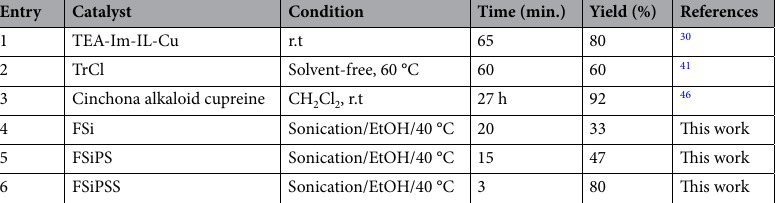
Entry Catalyst Condition Time (min.) Yield (%)